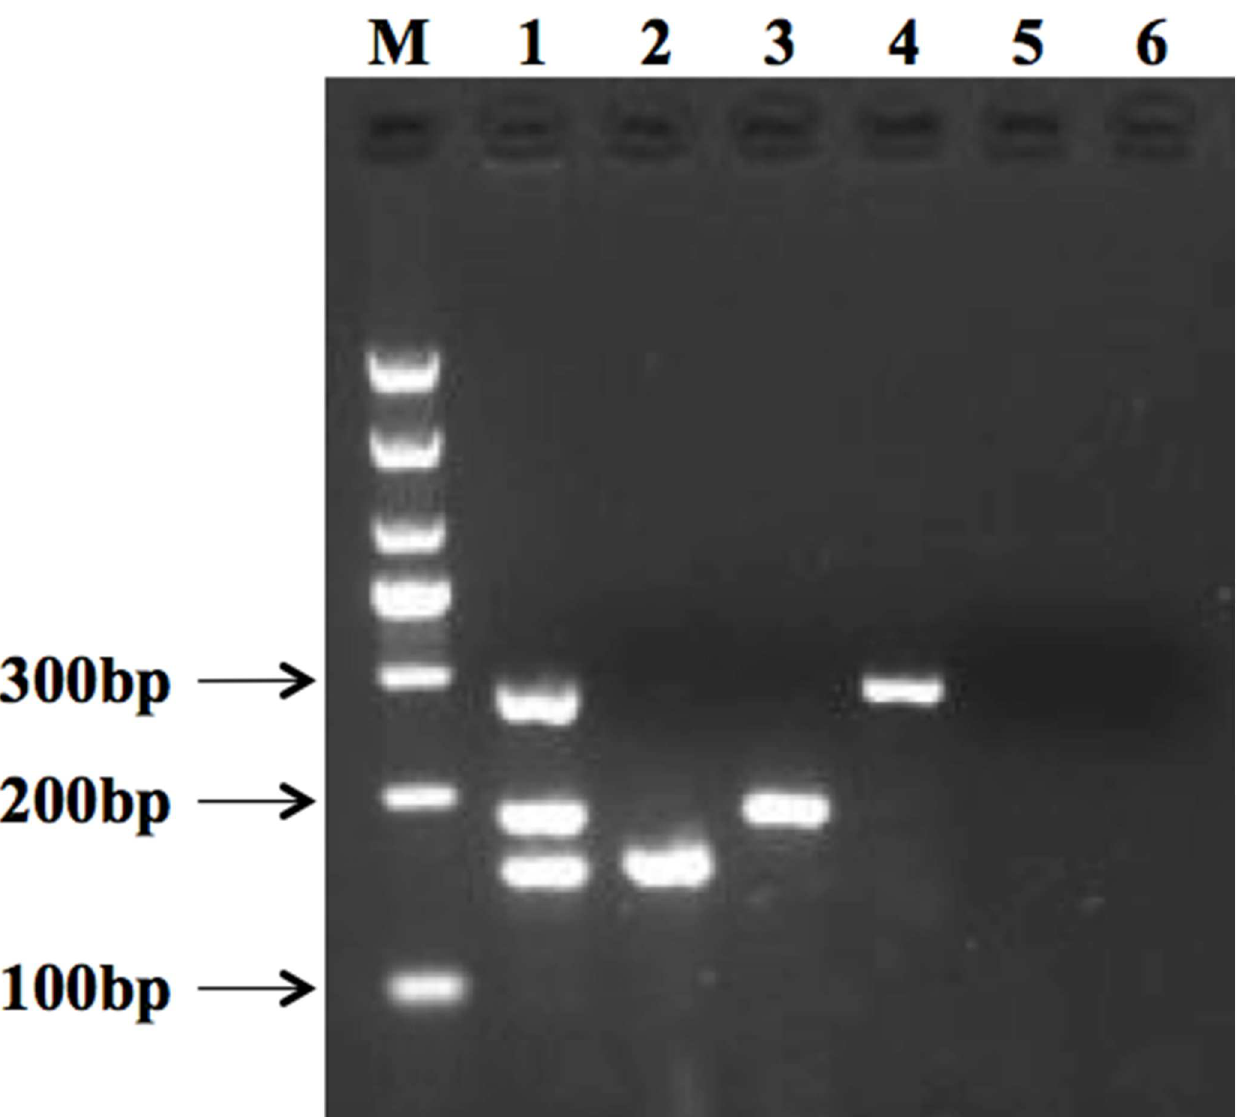
Fig 1. Multiplex PCR result of L . monocytogenes , E . coli O157:H7, and S . aureus , respectively. M: 1000 bp DNA marker. Lane 1 shows PCR amplicons,specific to L . monocytogenes (285 bp), E . coli O157:H7 (193 bp), and S . aureus (159 bp). Lanes2–4 show individualPCR amplicons,specific to S . aureus (159 bp) (lane 2), E . coli O157:H7 (193 bp) (lane 3), and L . monocytogenes (285 bp) (lane 4). Lanes5–6 show results for the negative control.